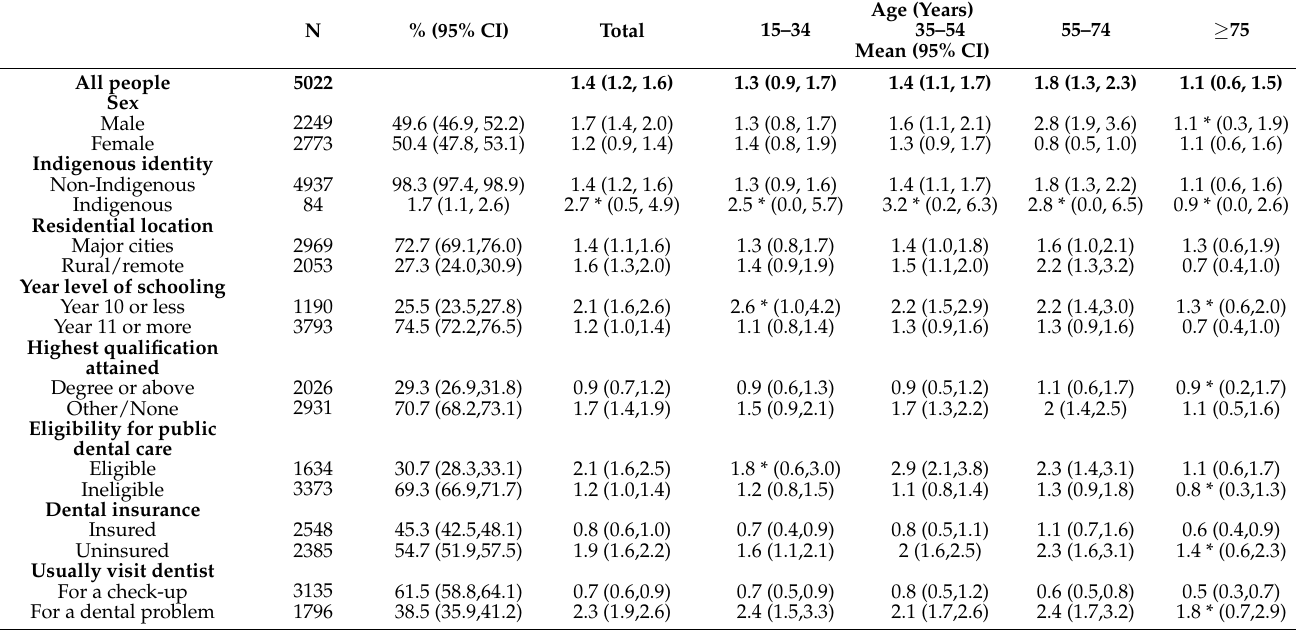
Table 2. Mean number of decayed tooth surfaces per person in the Australian dentate adults aged 15 years and